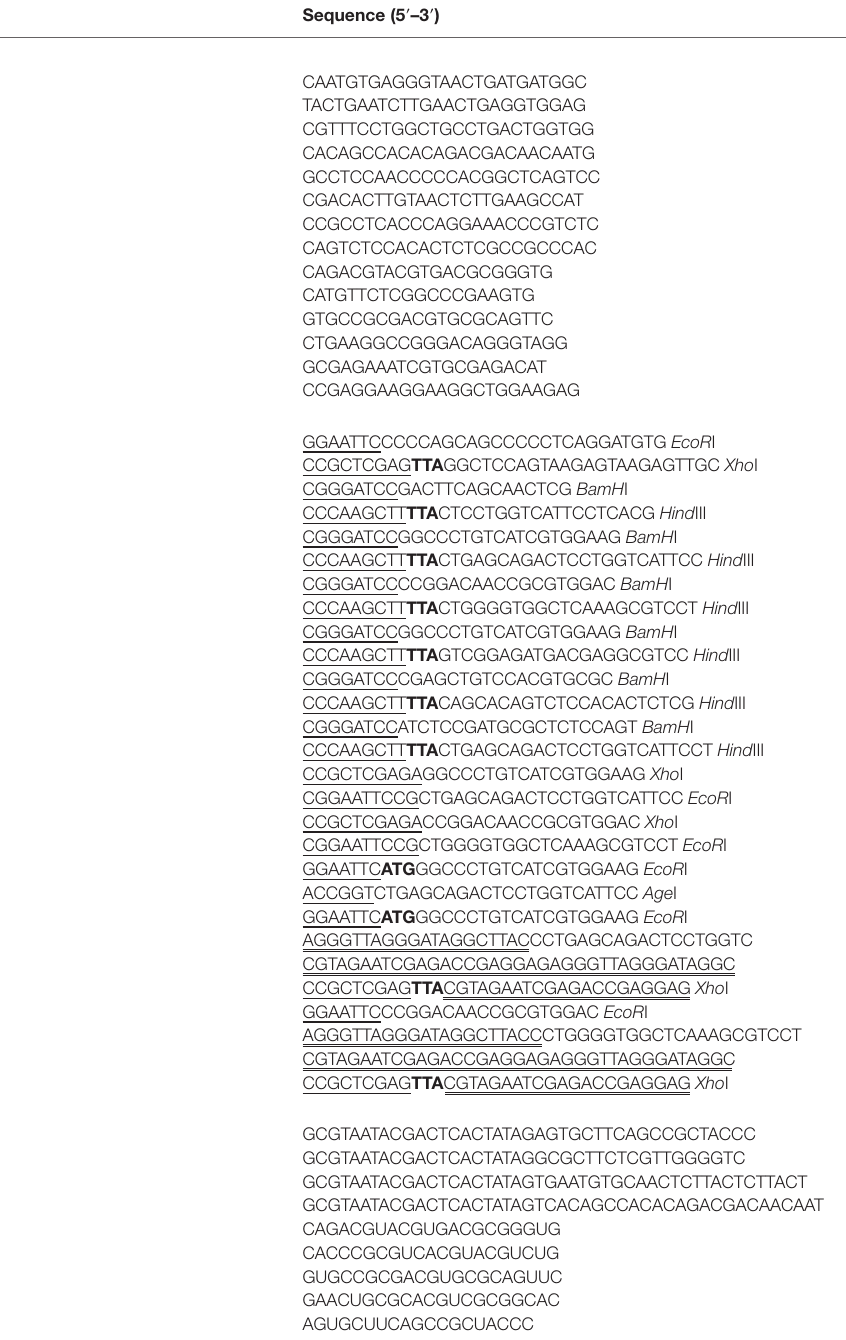
TaBle 1 | Oligonucleotide primers used in this study. Primers sequence (5 ′ –3 ′